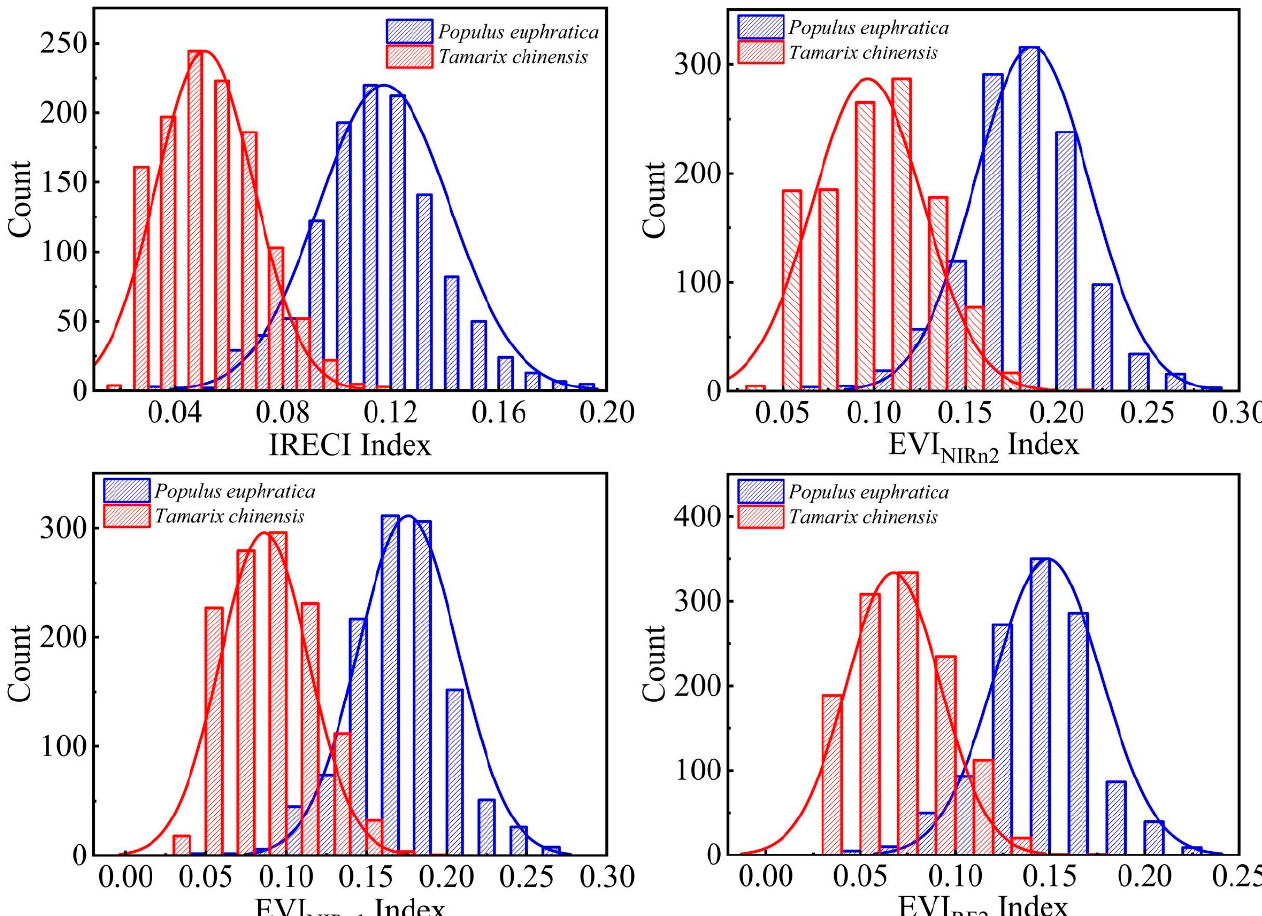
Figure 6. Frequency distribution of selected vegetation indices for reference samples.